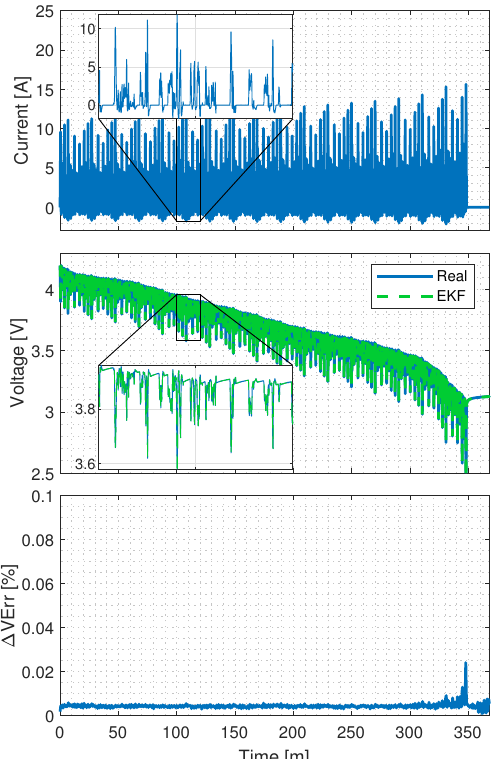
Figure 8. LG 1-A. Comparison between the output voltage estimated by the GO-EKF and real